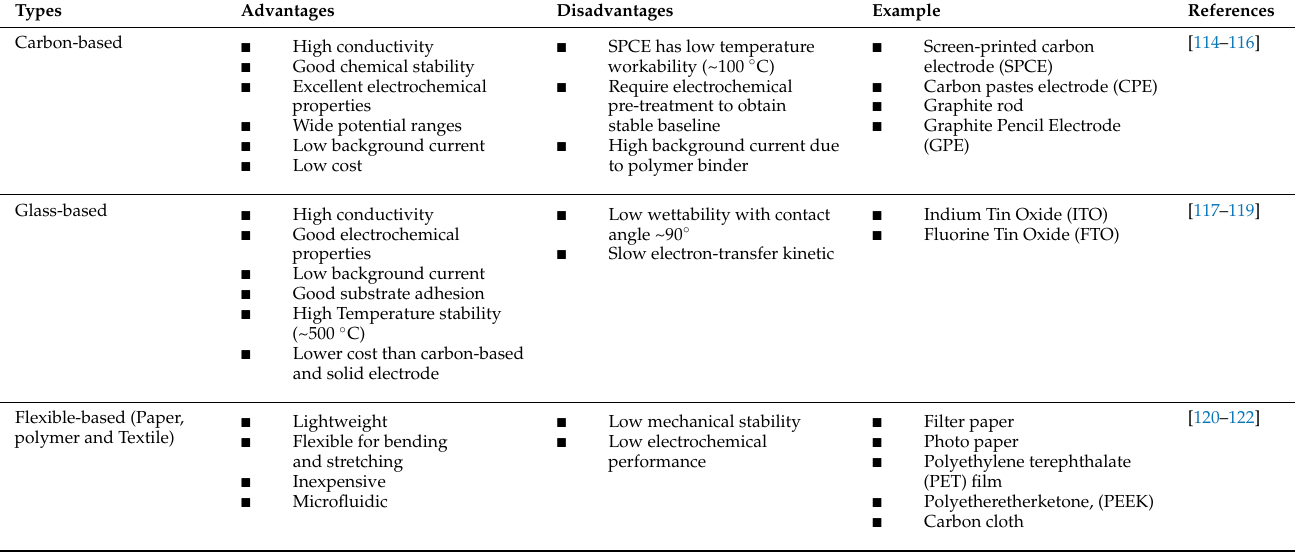
Table 2. Types of disposable electrode, advantages, disadvantages, and examples of each type of the disposable